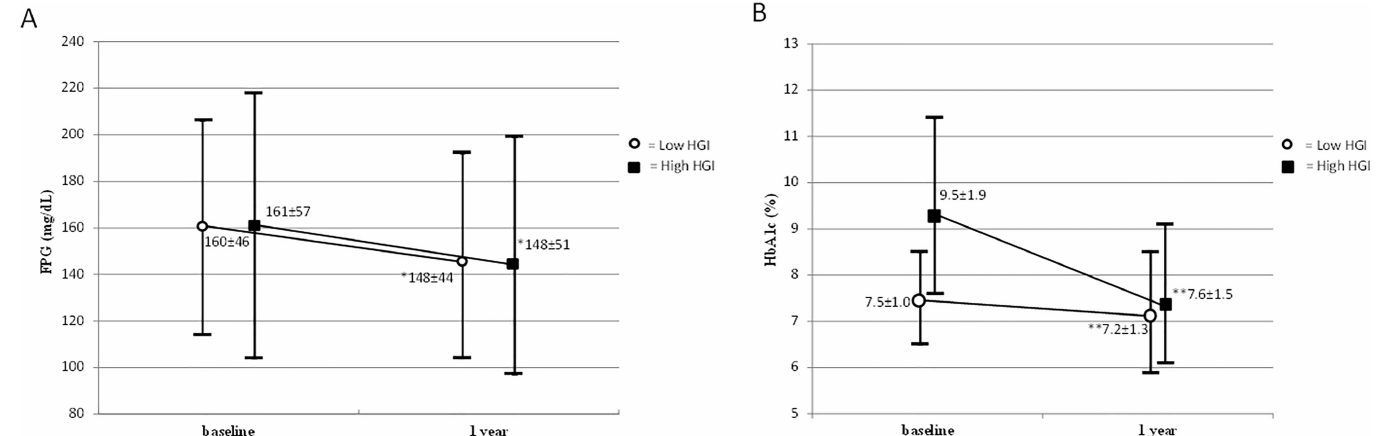
Fig 1. Mean value from baseline to 1 year of dipeptidyl peptidase-4 inhibitor treatment in two groups according to baseline hemoglobin glycation index (HGI) in fasting plasma glucose (FPG) ( p = 0.965) (A) and glycated hemoglobin (HbA 1 c) ( p < 0.001) (B). Data are presentedas mean ± standard deviation(SD). * p = 0.002, ** p < 0.001comparedwith baseline; where ‘ p ’ represents p -valueof between-groupdifference. (To convert glucoseto millimoles per liter, multiply by